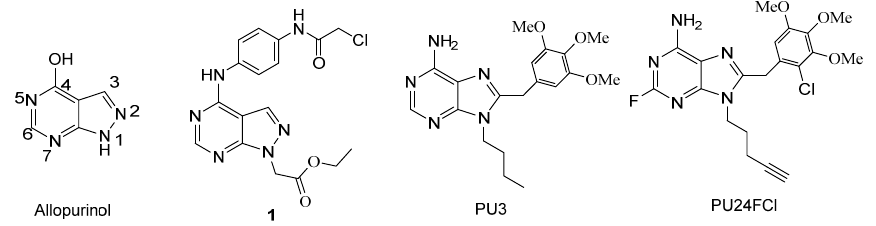
Figure 1. Structures of allopurinol, compound 1 , PU3, and PU24FCl.